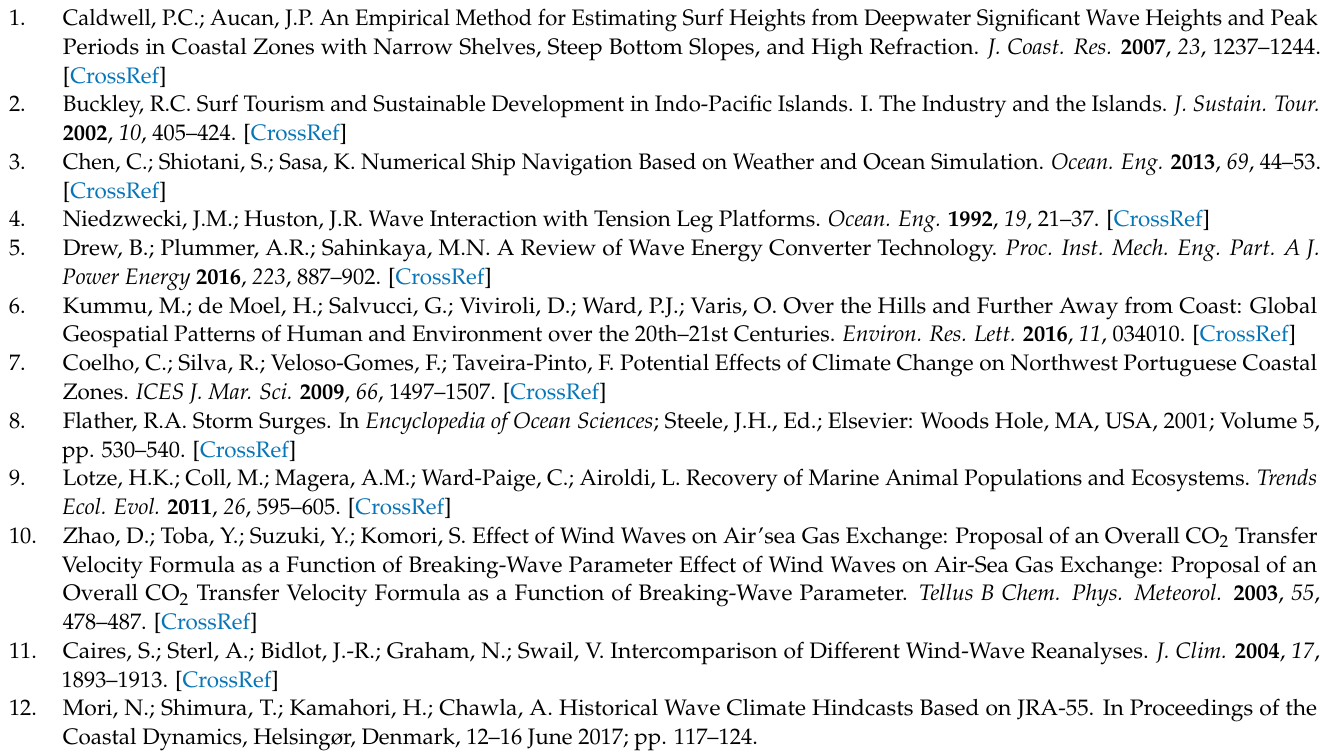
the differences between each future scenario and the AMIP scenario for January-April. Positive (negative) value indicates wave direction shifting clockwise (counter clockwise) in the future relative to AMIP values. Figure S5: The same as Figure S4, but for May-August. Figure S6: The same as Figure S4, but for September-December. Figure S7: Mean wave period ( T in second) results for AMIP scenario and the differences between each future scenario and the AMIP scenario for January-April. Positive (negative) value indicates increasing (decreasing) wave period in the future relative to AMIP values. Figure S8: The same as Figure S7, but for May-August. Figure S9: The same as Figure S7, but for September-December. Figure S10: Mean significant wave height (Hs in m) results for AMIP scenario and the differences between each future scenario and the AMIP scenario for each season. Positive (negative) value indicates increasing (decreasing) wave height in the future relative to AMIP values. Figure S11: Mean wave direction ( θ in degree) results for AMIP scenario and the differences between each future scenario and the AMIP scenario for each season. Positive (negative) value indicates wave direction shifting clockwise (counter clockwise) in the future relative to AMIP values. Figure S12: Mean wave period ( T in second) results for AMIP scenario and the differences between each future scenarios and the AMIP scenario for each season. Positive (negative) value indicates increasing (decreasing) wave period in the future relative to AMIP